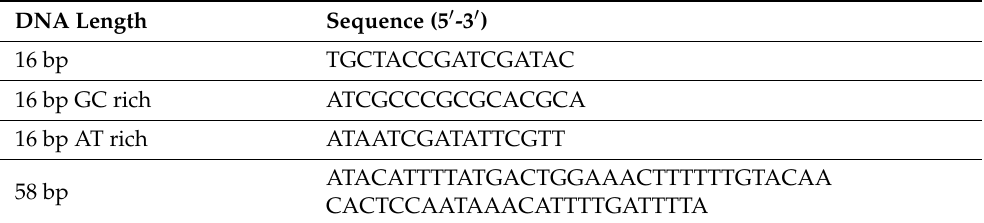
Table 2. List of single-strand DNA sequences. DNA